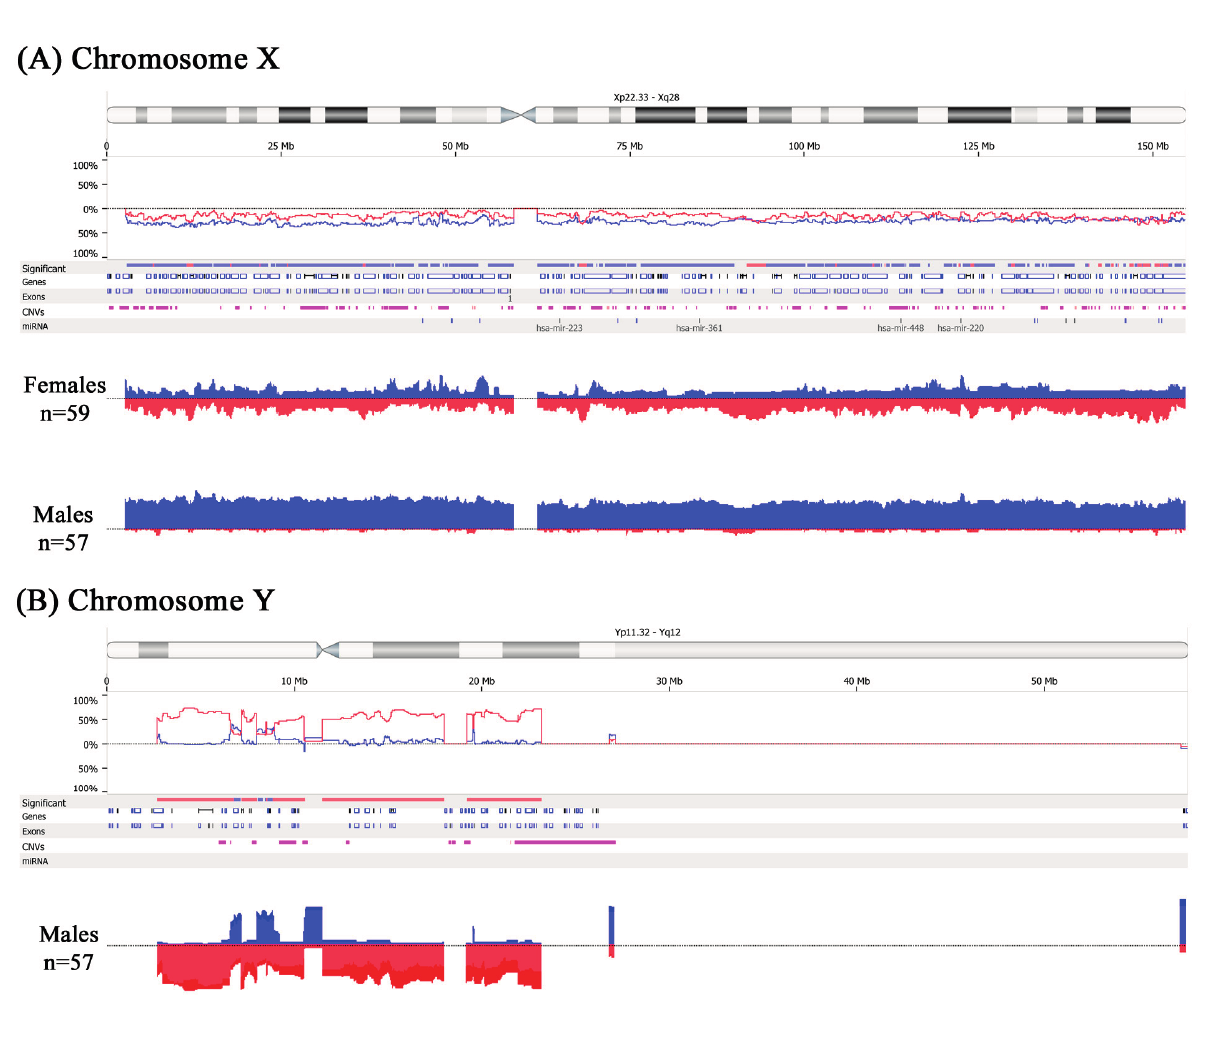
Figure 2. Sex-chromosome copy number aberrations in colorectal cancer cells by aCGH. Gains are depicted in blue and deletions in red. ( A ) Male cancers show extensive X chromosome gains while female cancers show equivalent frequencies of gains and losses; ( B ) Male cancers also show Y chromosome